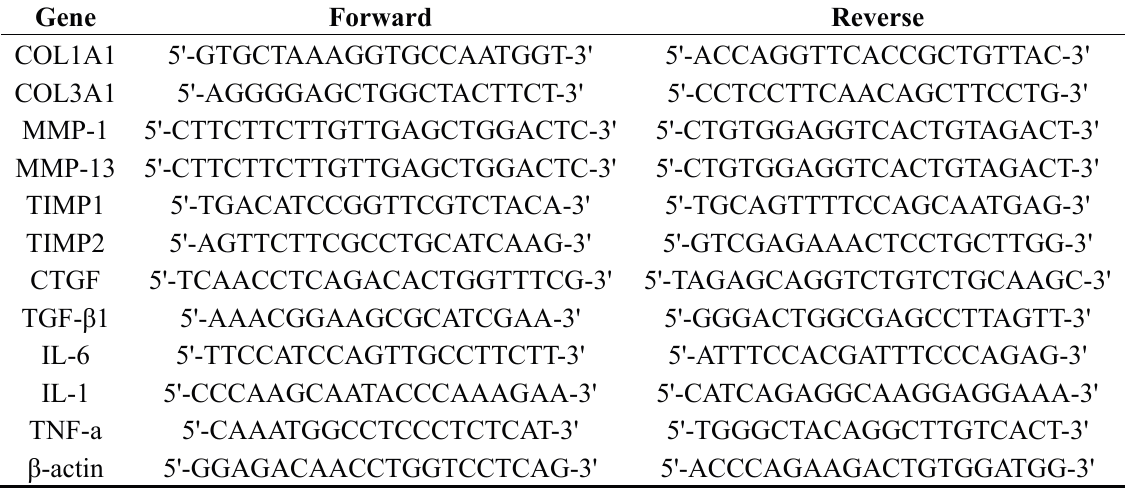
Table 1. The sequences of the primers used for qRT–PCR